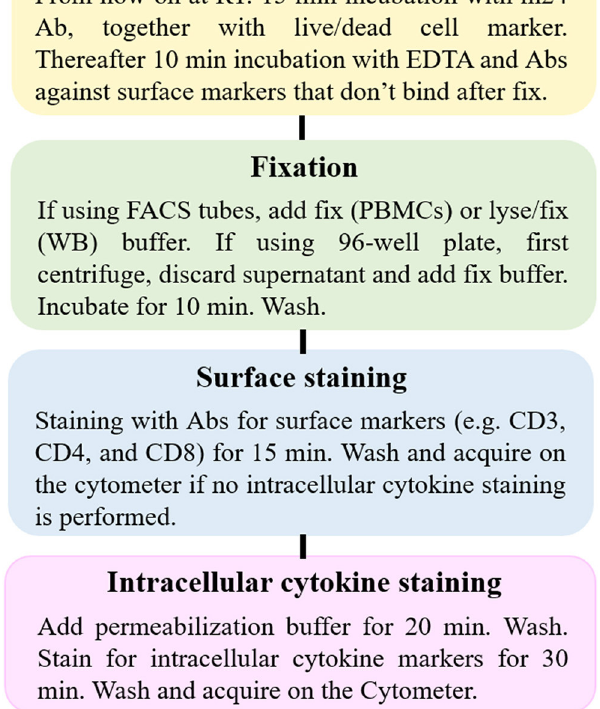
FIGURE 11 | The scheme of experimental procedure for flow cytometry-based detection of activated CD4 + and CD8 + T cells using m24 Ab. The procedure can be performed on WB or PBMCs, either in fluorescence-activated cell sorting (FACS) tubes (WB and PBMCs) or 96-well plates (PBMCs) and is divided into five main steps: (1) antigen-specific stimulation, (2) staining of activated β 2 -integrins with m24 Ab, followed by EDTA treatment, (3) fixation/erythrocyte lysis of WB or fixation of PBMCs, (4) cell surface marker staining, and (5) permeabilization and intracellular staining. Additional modifications can be made for covering different specific questions as indicated in the